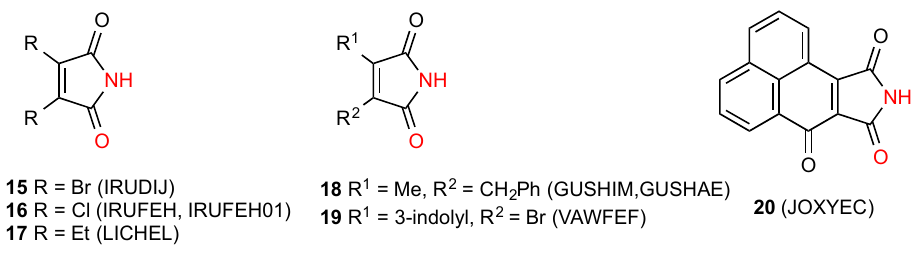
Figure 6. Disubstituted maleimides forming ribbon pattern B.